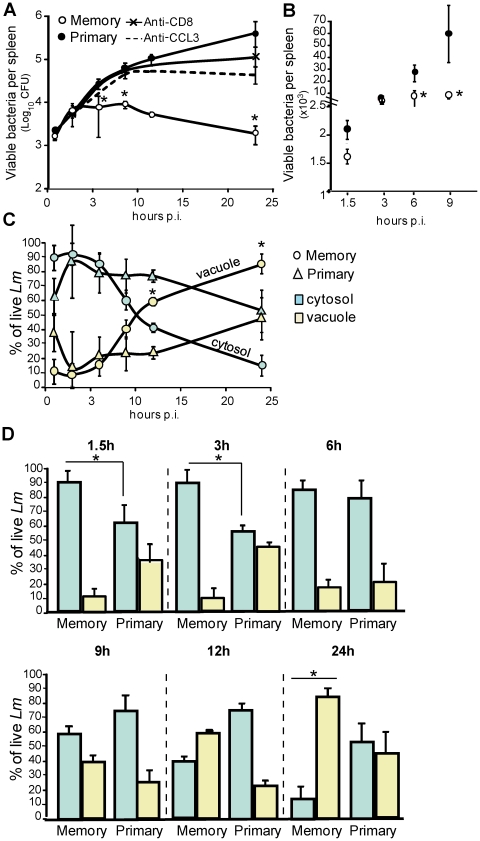
CCL3+ memory CD8+ T cells control bacterial growth during a secondary infection through a vacuolar and a cytosolic mechanism.(A–B) Primary and memory wt mice (10/group) were treated (A) or not (B) with anti-CD8 or anti-CCL3, and challenged with 3×105 wt Lm. Mice were sacrificed at the indicated times after the infection. (A–B) show the number of bacteria CFUs (mean +/− SE) in the spleen in a pool of 2 replicate experiments. P values were calculated between groups of mice injected with PBS or immunized with wt Lm (n = 10). (C–D) Primary (triangles) and memory mice (rounds) (9–12/group) were challenged one month later with 3×105 wt-L029 Lm. At the indicated times after infection, spleen cells treated or not with chloramphenicol, lysed and plated. (C) Graphs show the frequencies (mean +/− SE) of cytosolic (blue) and vacuolar (yellow) Lm CFUs in phagocytes in a pool of 3–4 experiments (n = 9). (D) is another representation of these data with histograms reporting frequencies (mean +/− SE) of cytosolic (blue bars) and vacuolar (yellow bars) Lm CFUs.